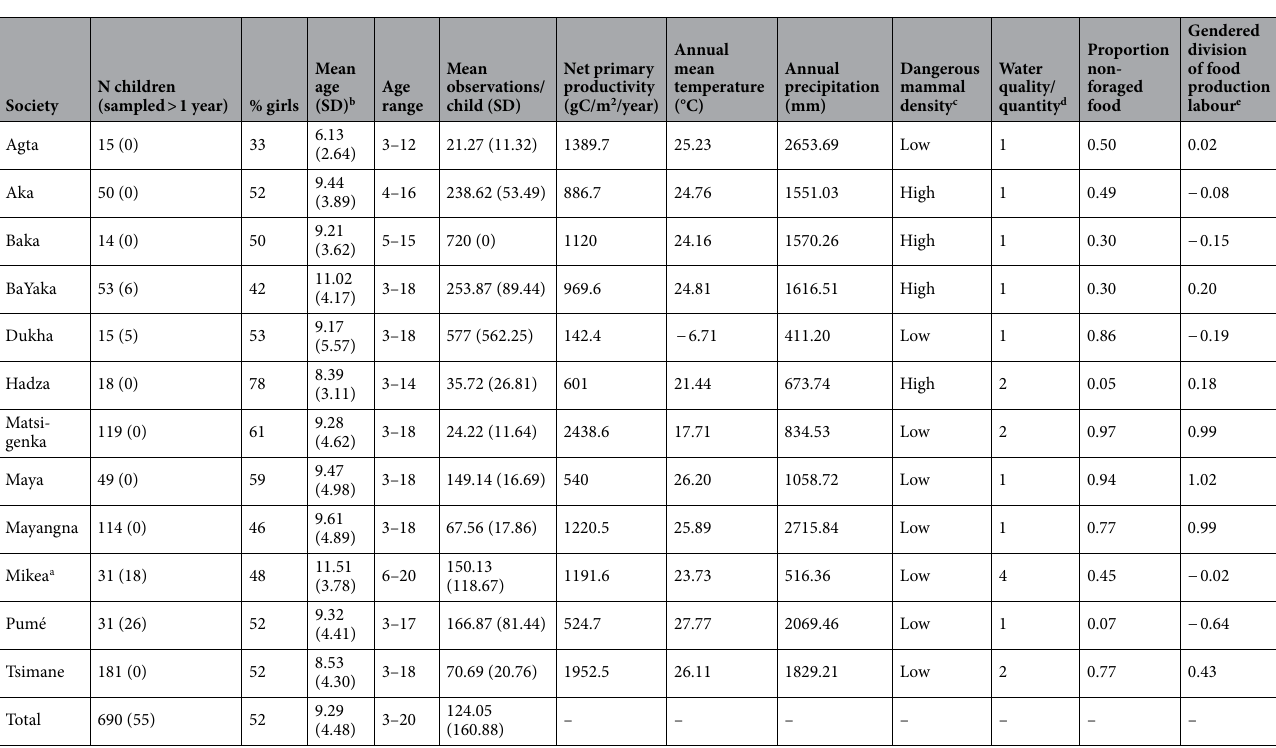
Table 1. Sample characteristics and summary statistics. a Exact ages for Mikea children were not